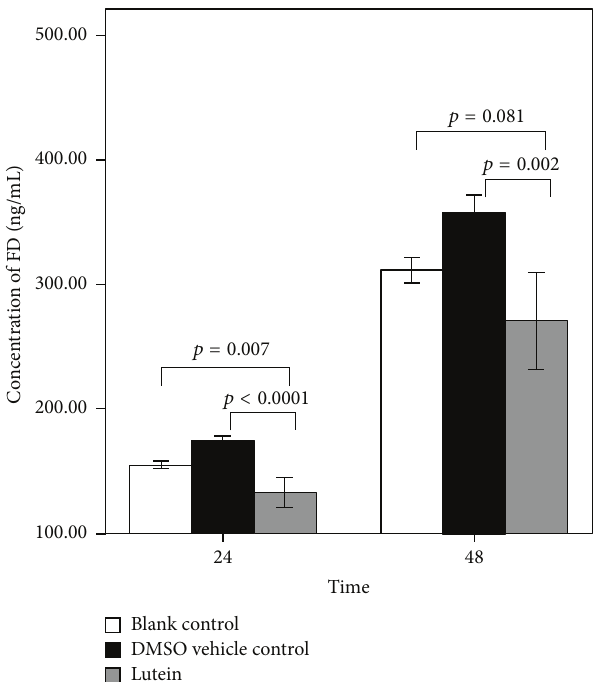
Figure 2: Factor D (FD) concentration in culture medium from 20-day differentiated SGBS adipocytes incubated for 24 h and 48 h in culture medium (blank control), 0.5% DMSO (DMSO vehicle control), or lutein (50 𝜇 g/mL) in the presence of 0.5% DMSO (lutein).